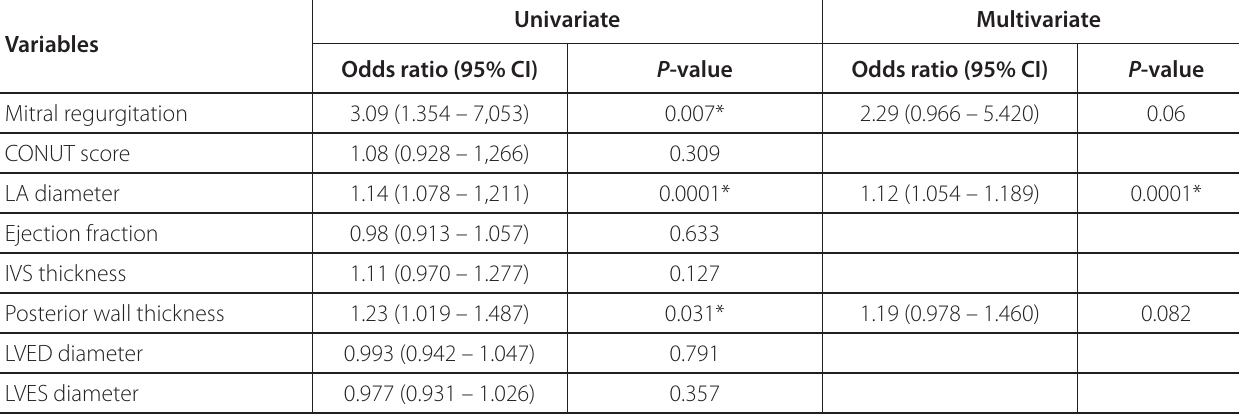
Table 4 . Univariate and multivariate logistic regression analysis of parameters predicting the existence of